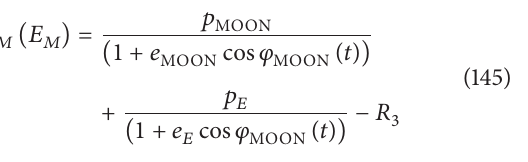
(𝜑 (𝑡)) between the combined for the distance 𝑟 MOON MOON and the mass center 𝐶 of the mass center 𝐶 3, MOON MOON Moon and for the distance 𝑟 𝐸 (𝜑 𝐸 (𝑡)) between the combined and the mass center 𝐶 3 of the Earth mass center 𝐶 3, MOON 𝑝 𝜏 and the eccentricity 3 . We have the focal parameter MOON 𝑒 of the elliptical orbit of the Moon. 𝑝 𝐸 and 𝑒 𝐸 ( 𝑒 𝐸 = MOON 𝑒 ) are the focal parameter and the eccentricity, respec- MOON